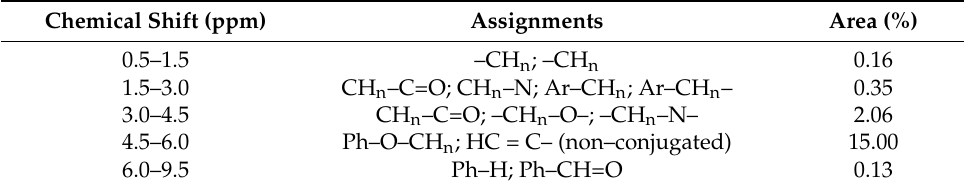
Figure 4. 1 H NMR spectrum of AM07Ac extract at 400 MHz. Table 1. Spectroscopic characterization by 1 H NMR of extract